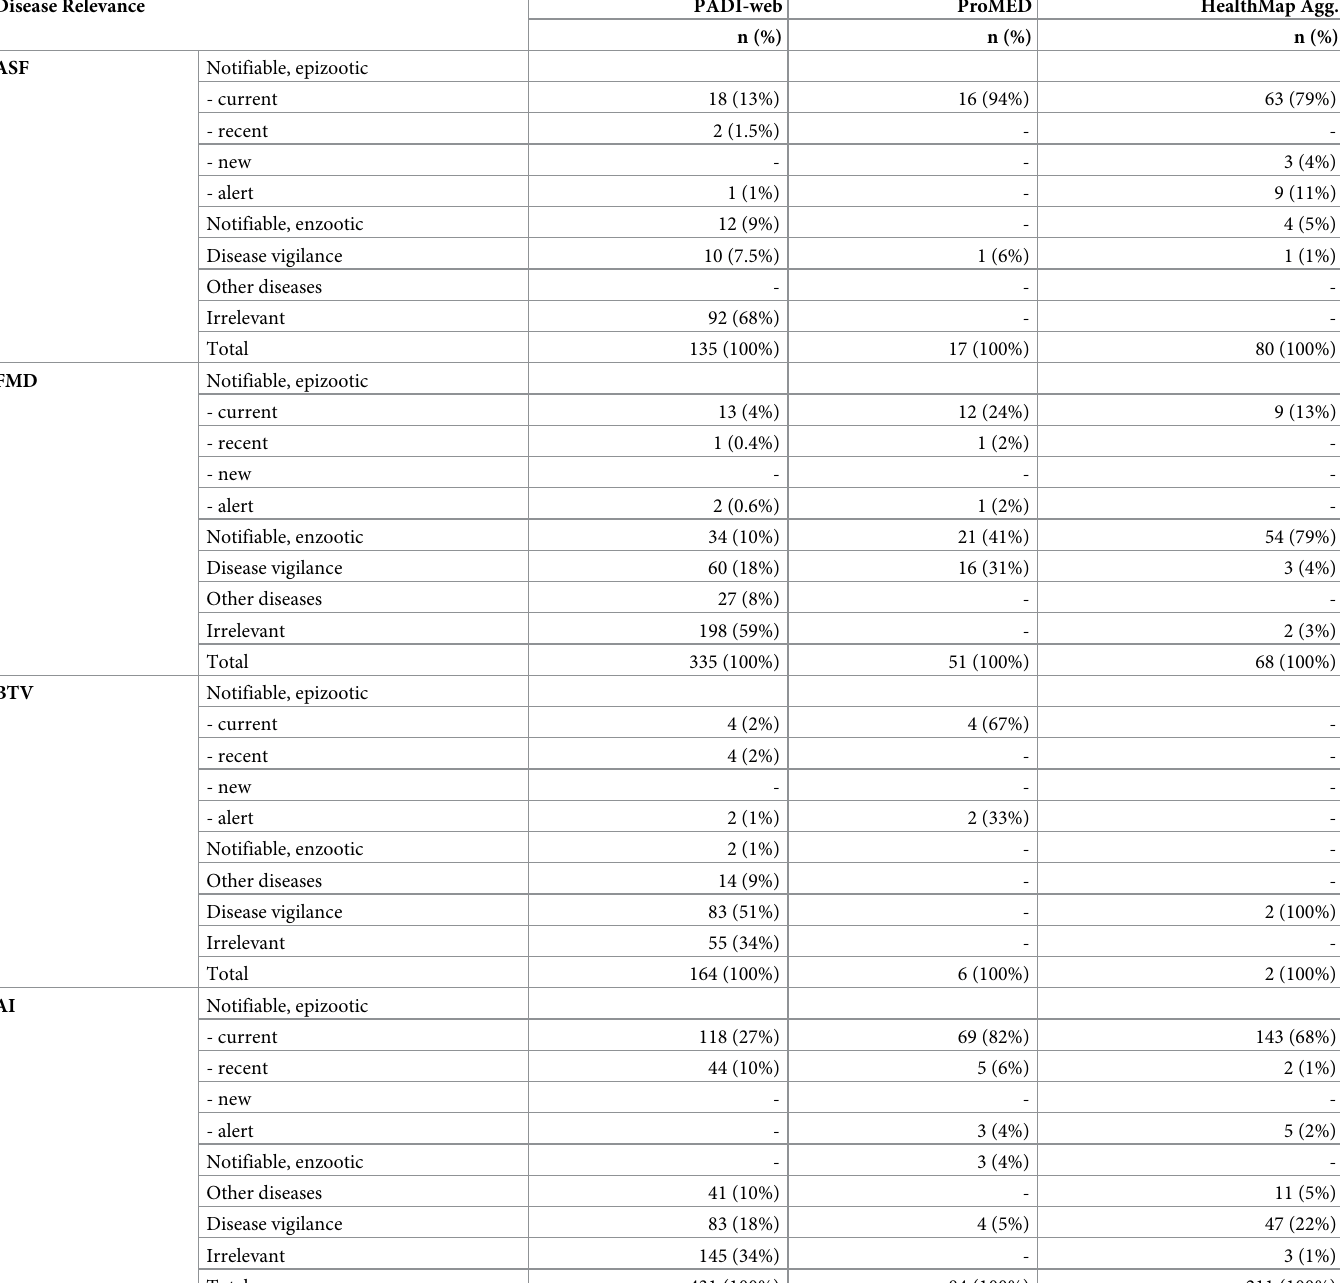
Table 3. Relevance of signals detected by PADI-web, ProMED and HealthMap (Agg.) for African swine fever (ASF), foot-and-mouth disease (FMD), bluetongue (BTV) and avian influenza (AI), from January to June 2016. Disease